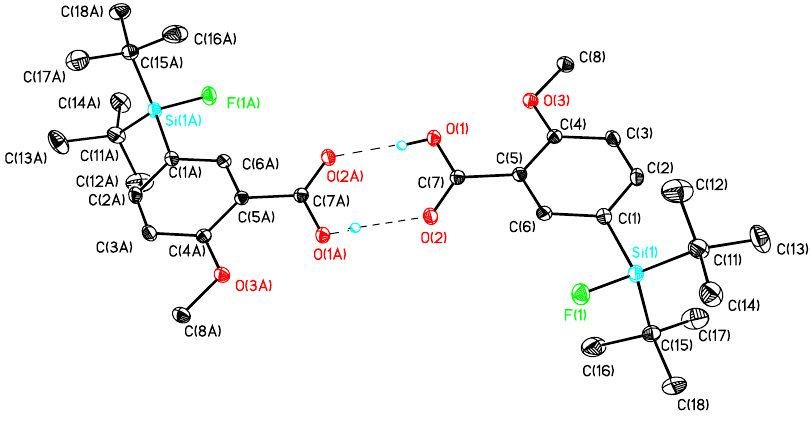
Figure 4. Molecular structure of 12a . Atomic displacement parameters are drawn at 30% probability level.